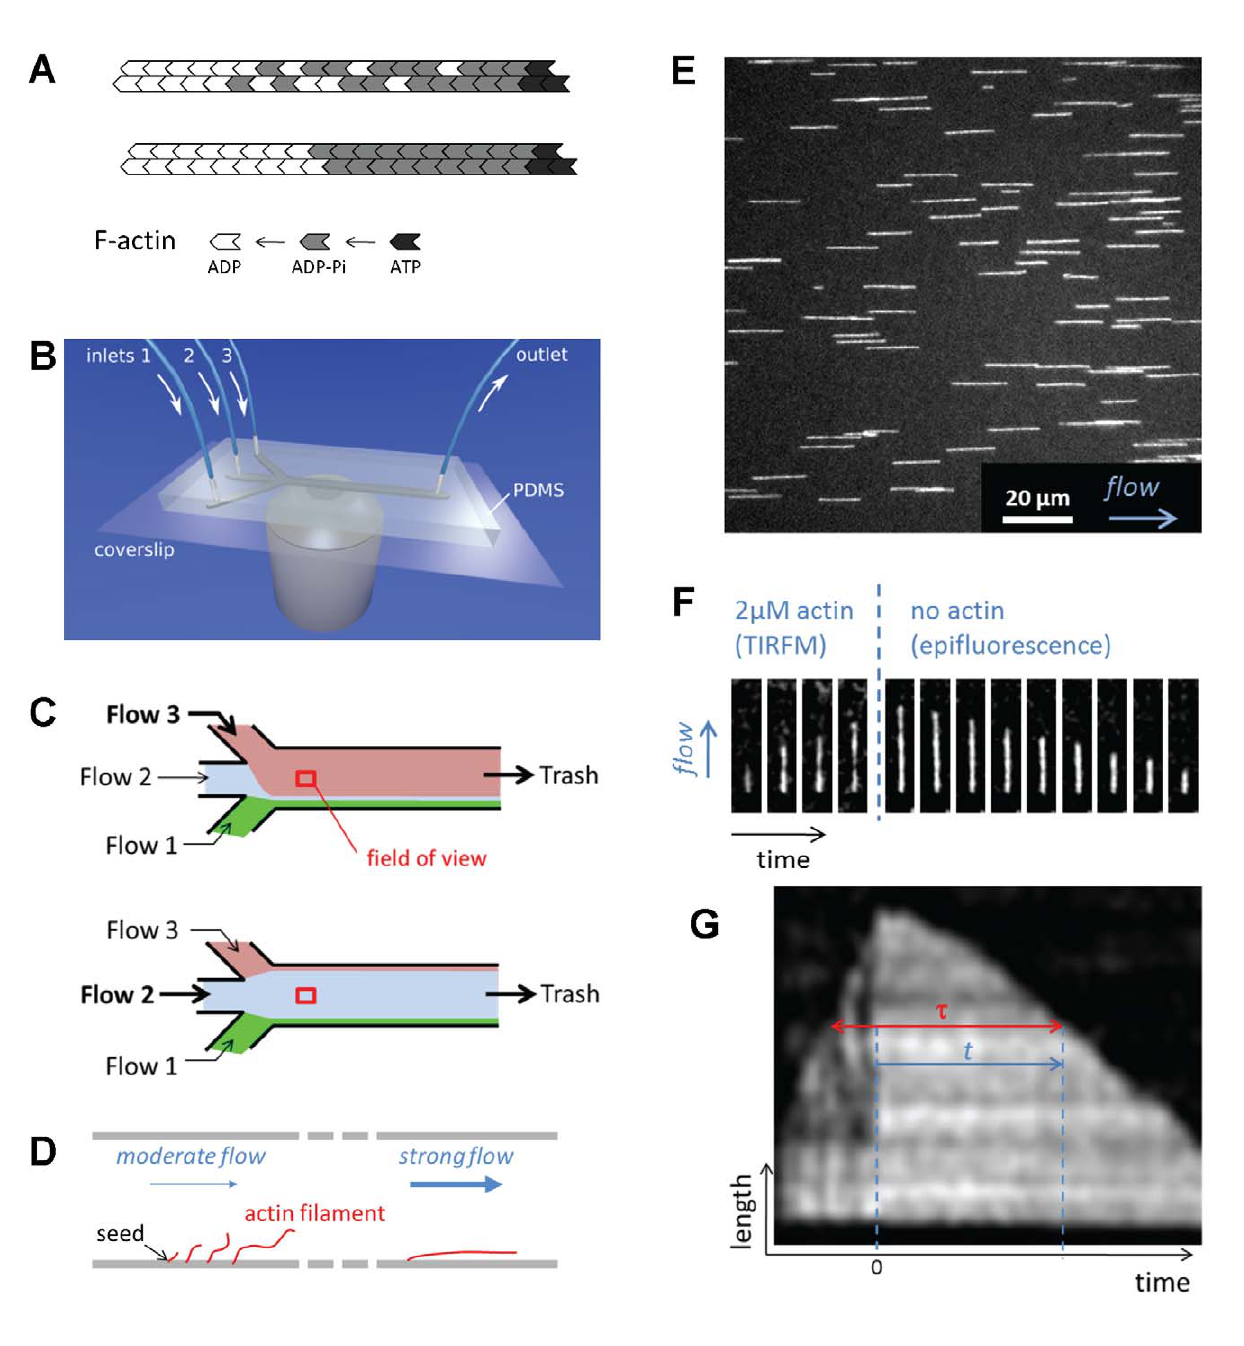
Figure 1. Microfluidics setup for the observation of individual actin filaments. (A) Random (top) or vectorial (bottom) model for Pi release in actin filments. (B) Microfluidics flow-cell on a microscope objective. (C) Flow-cell seen from above. The dominant laminar flow determines which medium occupies most of the flow-cell. (D) Side view of the flow-cell. When the microflow is sufficiently fast, the filaments align and remain close to the glass coverslip. (E) Epifluorescence image of filaments anchored to the coverslip of a flow-cell via spectrin-actin at their pointed end (left end), and aligned with the buffer flow (arrow). (F) Time lapse images of a single filament, observed in TIRF during elongation (1.5 m M actin, during 5 min) and epifluorescence during depolymerization. (G) Kymograph of the filament shown in (F). The age t of the subunits that dissociate at time t of the depolymerization process is indicated by the red line. doi:10.1371/journal.pbio.1001161.g001 assume that the dissociation rate of each actin subunit from the by the nucleotide state of neighboring subunits. Since Pi release is barbed end depends only on its nucleotide state, and not on that of slow compared to barbed-end depolymerization, it does not take its neighbors. In contrast, we make no hypothesis on Pi release, place significantly within a sufficiently small segment while this which takes place in the core of the filament and may be affected segment disassembles (see Text S1, equation 9). Thus, the